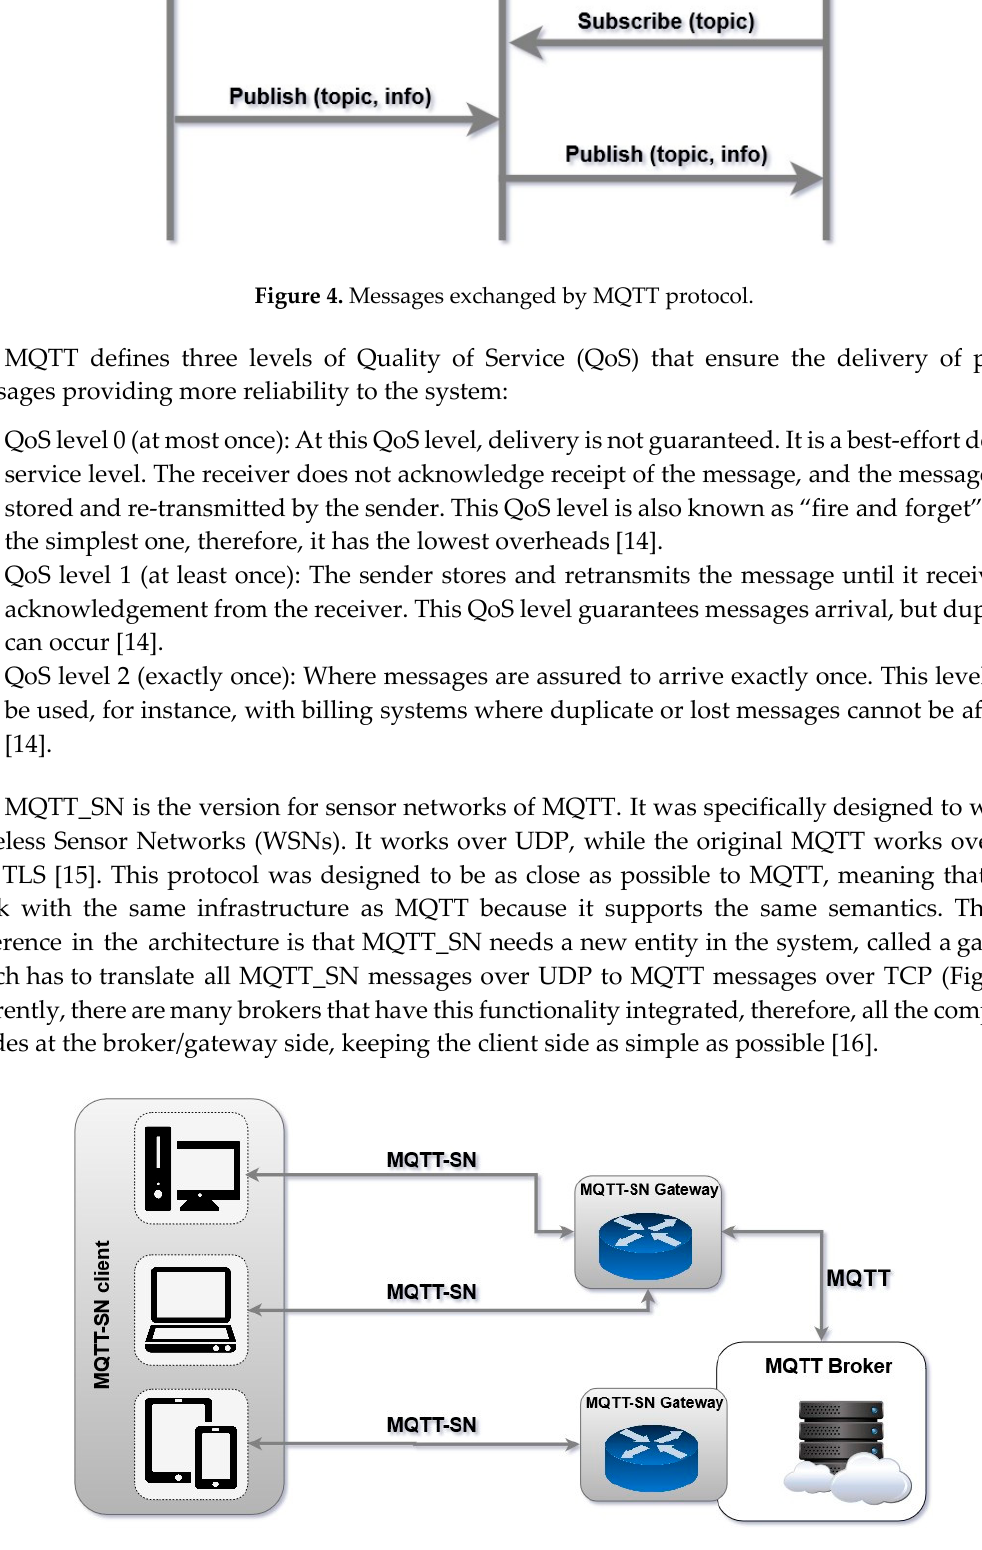
Figure 5. Publish/Subscribe pattern followed by the MQTT for sensor networks (MQTT_SN) protocol including the gateway